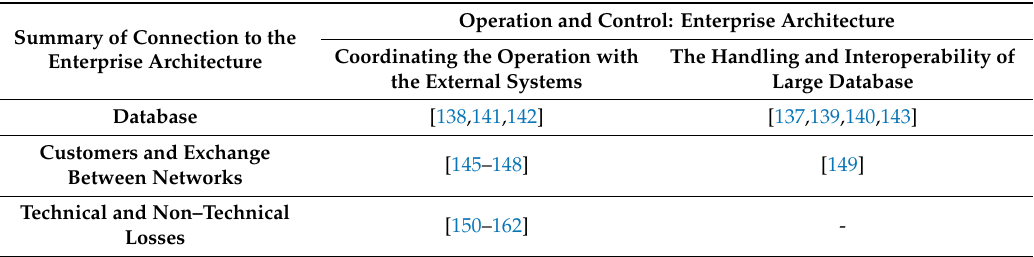
Table 6. Summary of Connection to the Enterprise